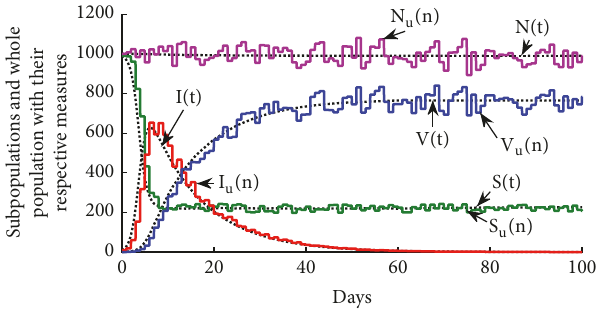
with uncertainties in the synthesis of the control signal without uncertainties Figure 23: Vaccinated subpopulations with (i) the vaccination strategy designed if there are uncertainties in the measures of the subpopulations and (ii) the basic vaccination strategy without uncertainties.